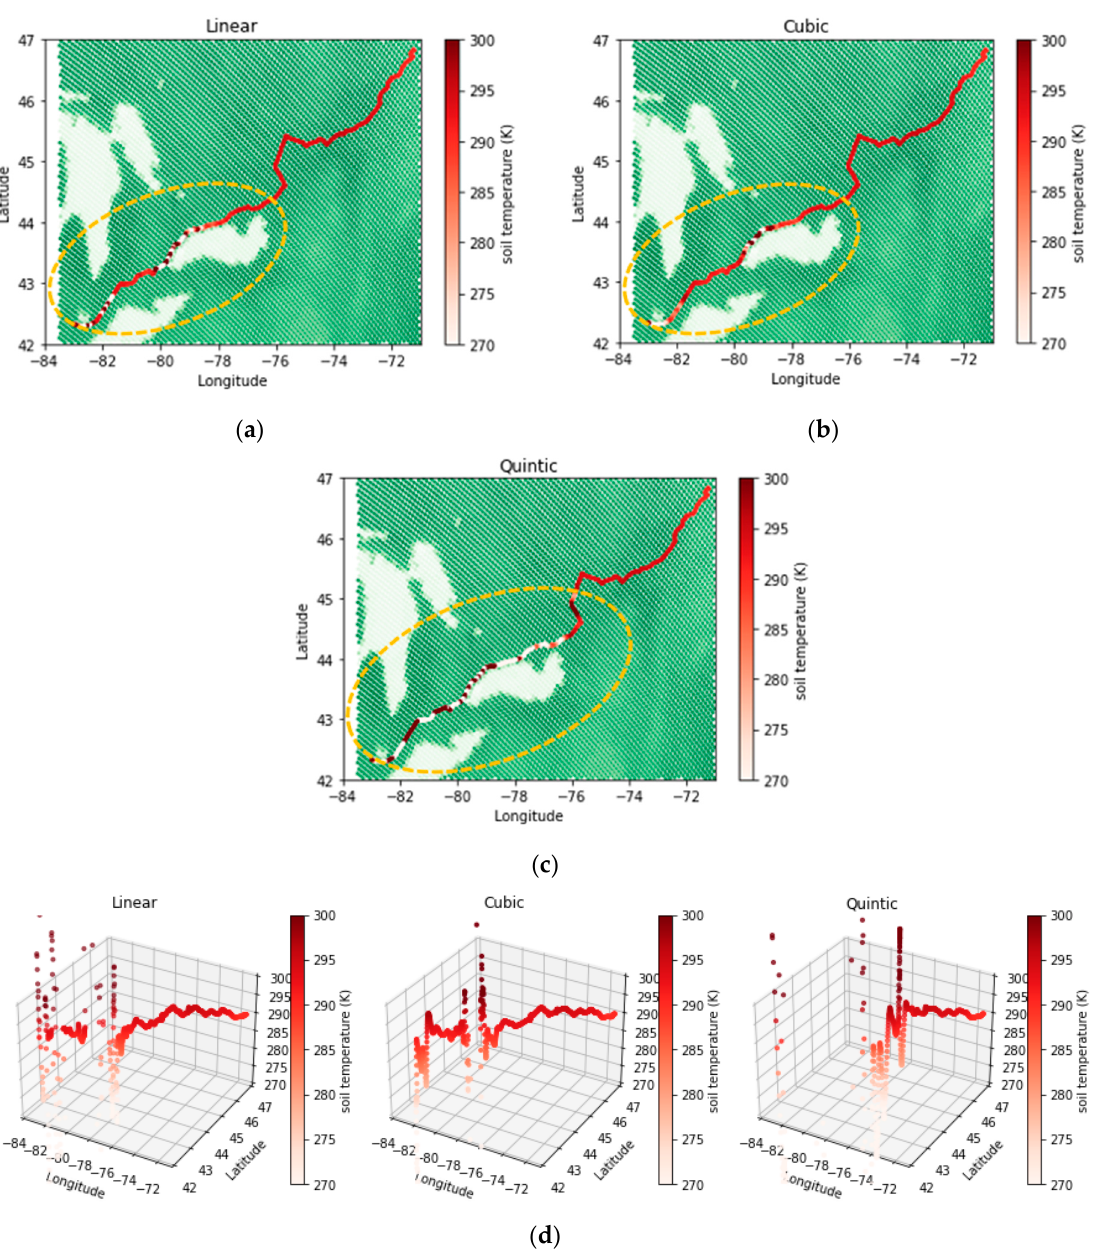
Figure 5. Interpolated soil temperature calculated by ( a ) linear method ( b ) cubic spline method ( c ) quintic spline method ( d ) 3D graphs for spline results.